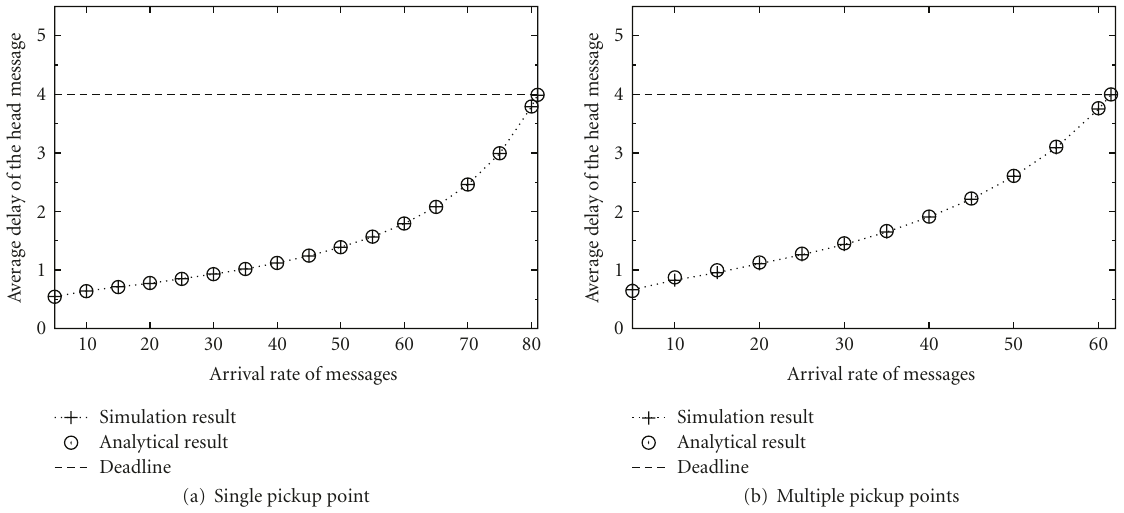
Figure 3: Comparison of delay for on-demand strategy.